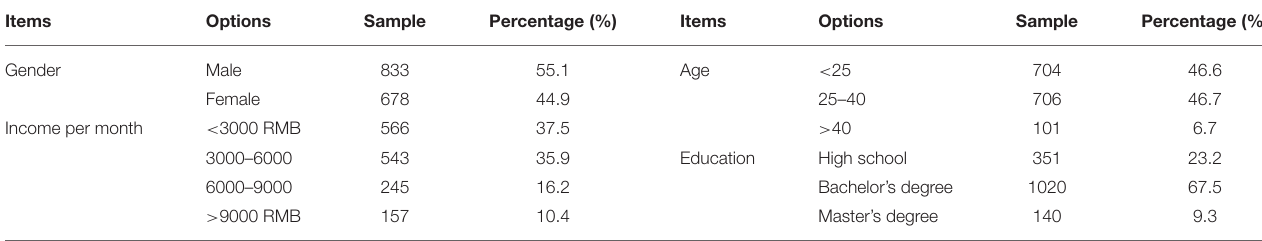
TABLE 1 | Demographic information of sample ( N = 1511).